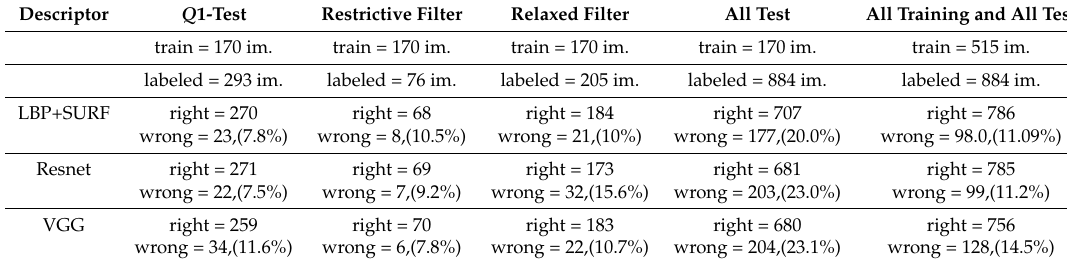
Table 6. Performance achieved with the combination MST+SVM for scene recognition described in Section 4. The SVM was trained using only the most relevant training images ( Q 1). The first column shows the results without the MST (the Q 1-test images are used after all test images have been sorted using the coverage metric). The second and third column show the role of the MST automatizing the filtering of images, no sorting of the test set has been carried out in these cases. We can also see how many of the 293 relevant images pass the MST filtering. The percentages are given with respect to the total number of images of the test set that have been labeled by the